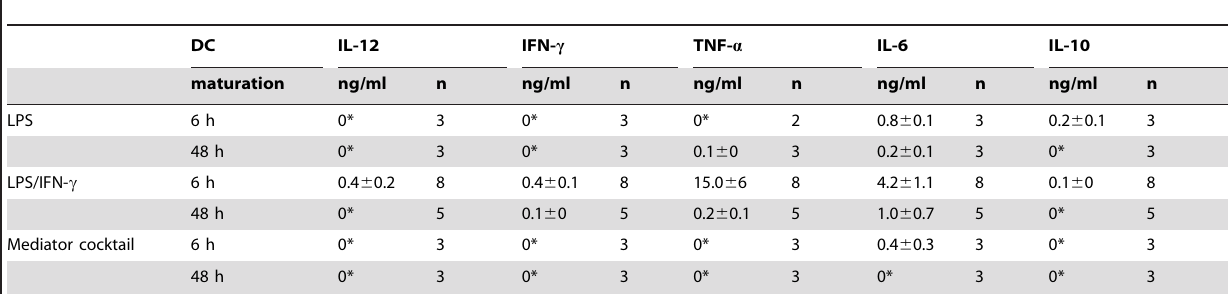
Table 2. Cytokine content of the DC/T-cell co-culture supernatant (6 and 48 hours DC stimulation) before sorting (median 6